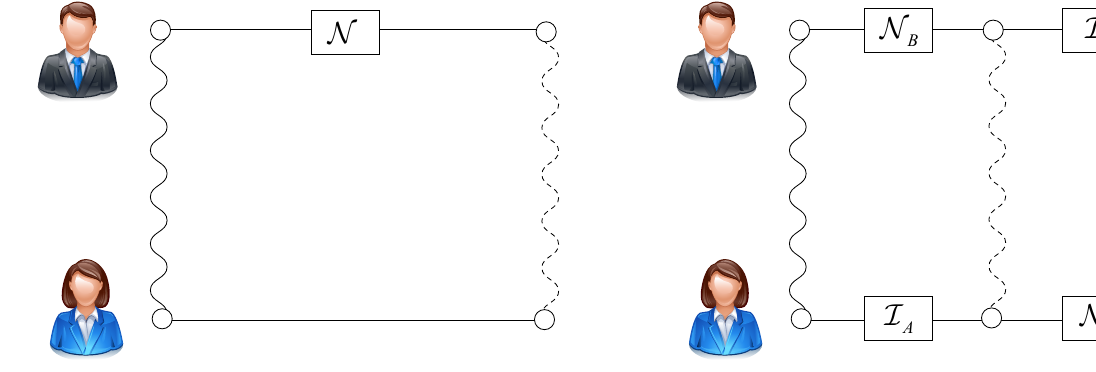
Figure 2: Sequential interaction where N B and N A stand for local channels acting on Bob’s and Alice’s side respectively. I I B and A represent identity operations on respective